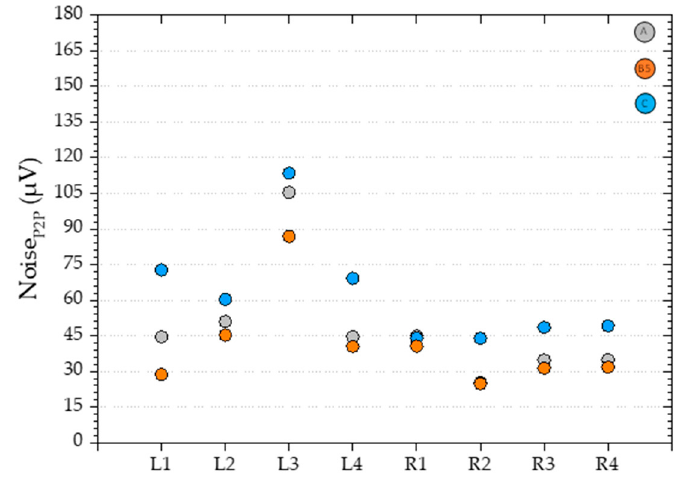
Figure 10. Comparison between the noise P2P ( µ V), for all eight sensors (L1–R4), at H = 0 T using a Keithley 220 as a current source, Keithley 182 voltmeter, and micrometric probes directly on to the contact pads of the Si chip ( ), the FPC with the Si chip bonded with the epoxy cured at 250 °C for 30 min ( ) and the same but using the electronic interface described in Section 3.5 ( ).